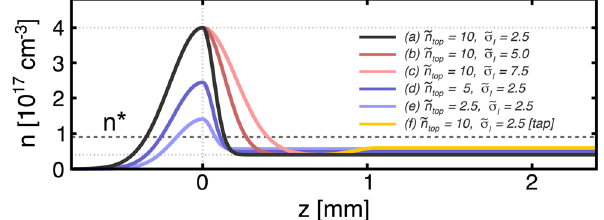
FIG. 7. Different plasma density profiles considered in the PIC